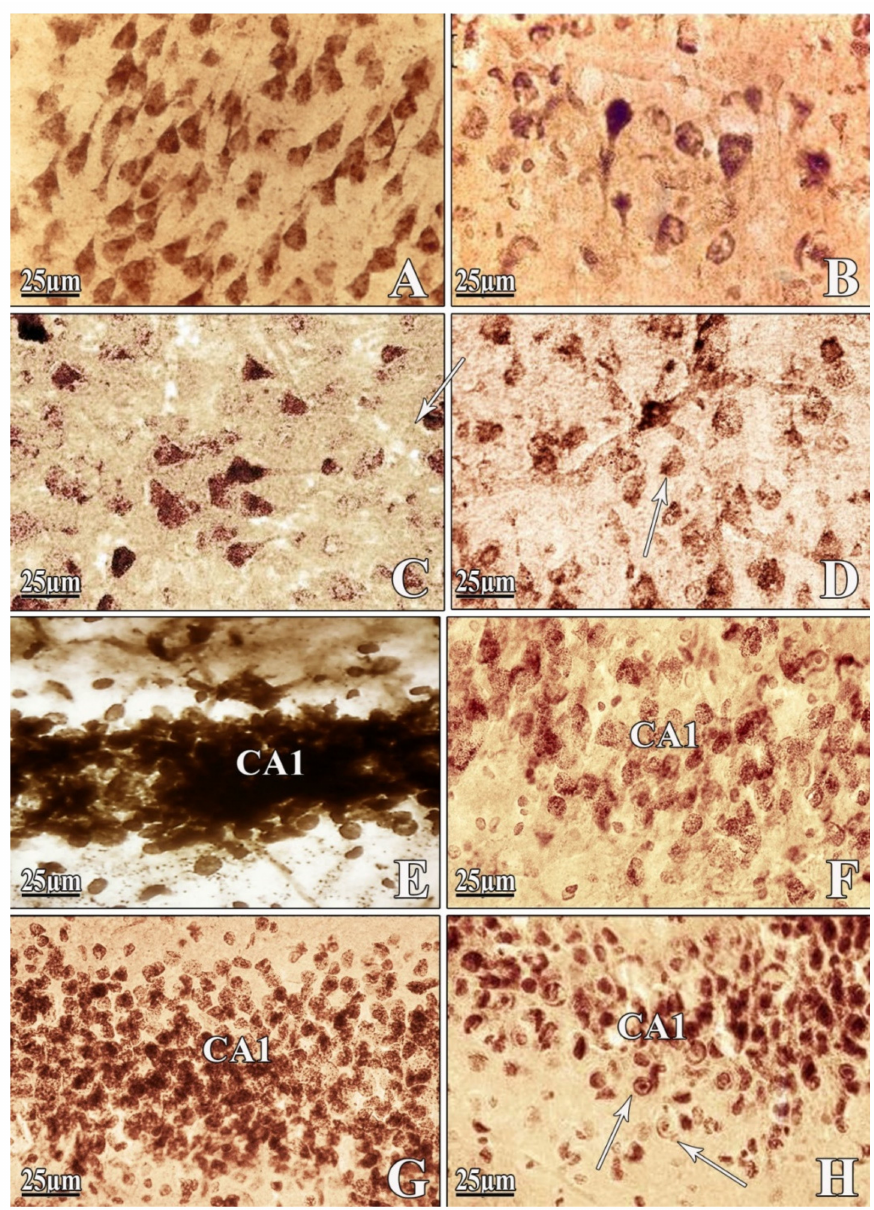
Figure 3. Frontal slices of the cerebral cortex and CA1 region of hippocampus. Pyramidal neurons of the cerebral cortex in normal conditions ( A ), after bilateral i.c.v. injection of A β 25–35 ( B ), and under the influence of PEG in PEG-1 ( C ) and PEG-2 ( D ) groups. Slices of CA1 neurons of intact rats’ brain hippocampus ( E ), after bilateral i.c.v. injection of A β 25–35 ( F ) and of PEG-1 ( G ) and PEG-2 groups ( H ). ( B )—chromatolysis, the eccentrically located nucleus and nucleolus of pyramidal neurons of the cortex; ( C , D )—densely distributed neurons; granulation in soma and processes of neurons of the cortex; ( G )—fine-grained sediment in soma of dentate gyrus neurons; satellites; ( G , H )—proliferation of neurons in the hippocampal CA1 field (white arrows indicate centrally located nucleus). Magnification: × 400 ( E – H ); × 1000 ( A – D